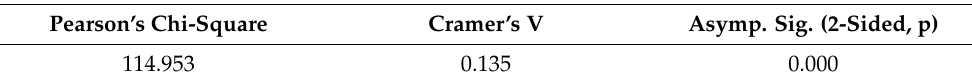
Table 6. The statistical relationship values for relation between the class number and frequency of public transport use.